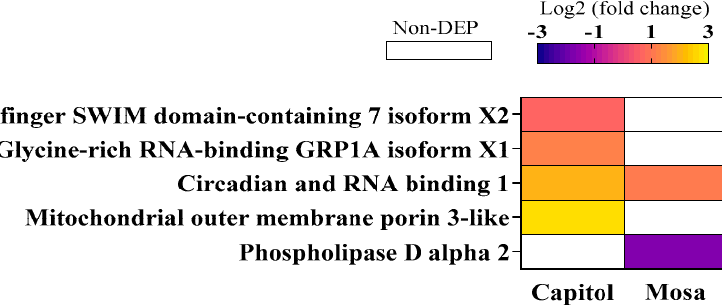
Figure 6. Differentially accumulated proteins involved in the plant innate immune responses in